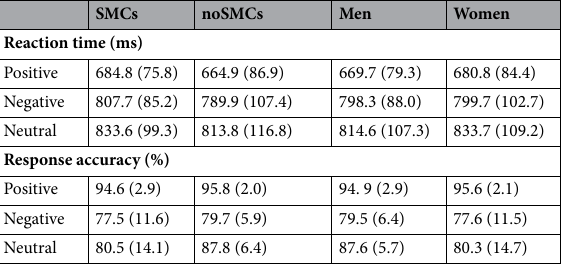
Table 2. Means and standard deviations for the behavioral performance for each group and sex. ms milliseconds, SMCs subjective memory